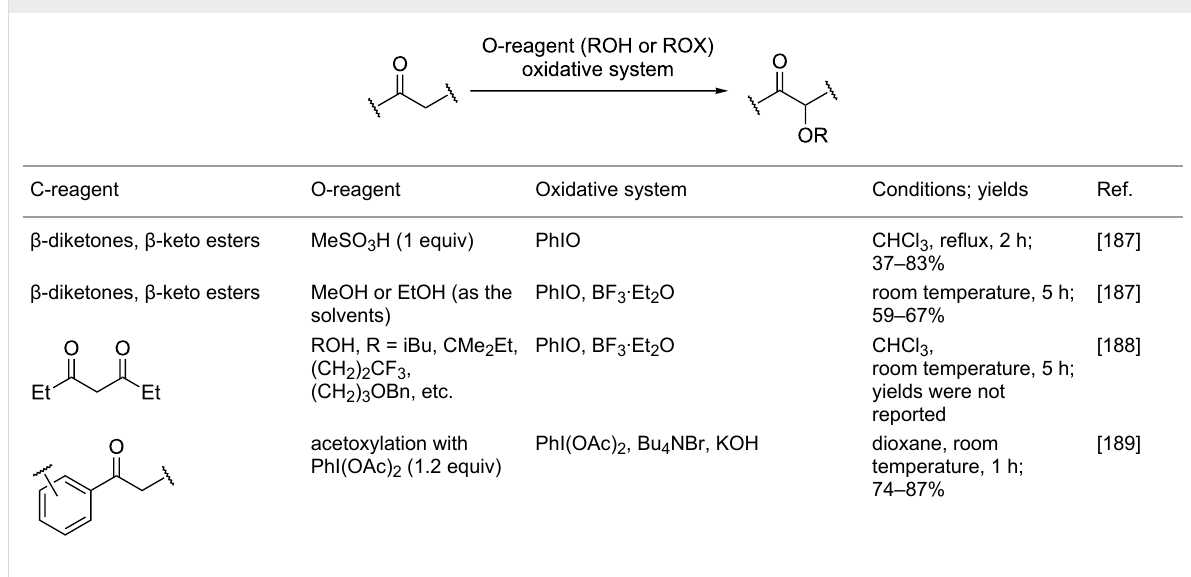
Table 6: C–O coupling reactions at the α -position of carbonyl compounds mediated by iodine(III) compounds or iodoarenes in the presence of perox- ides.